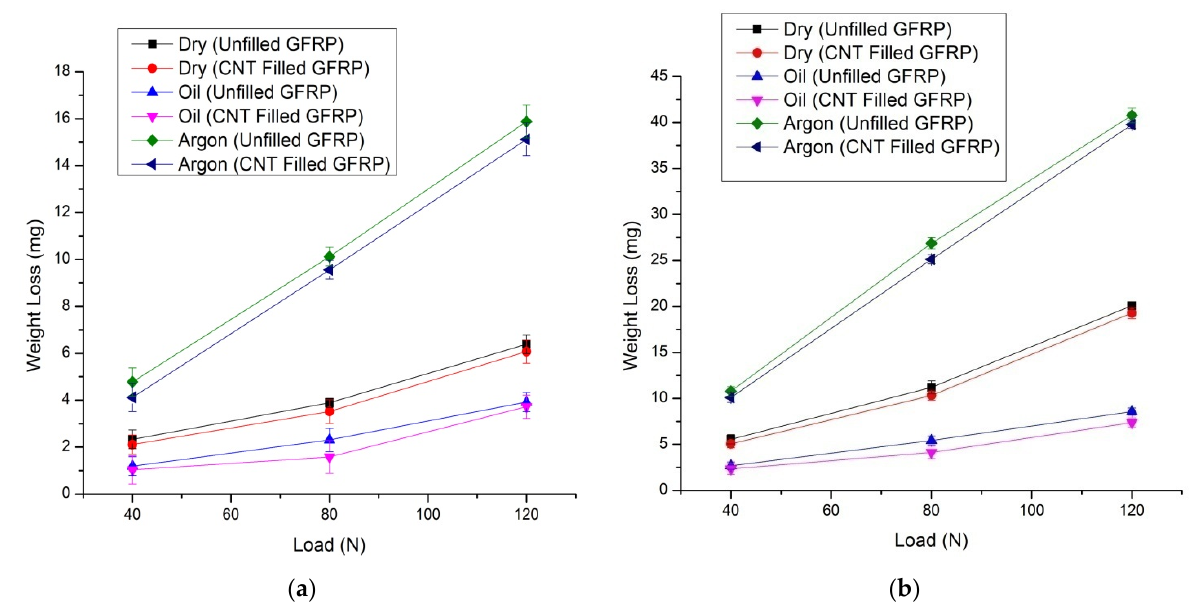
Figure 3. ( a ) Wt. Loss v/s Load for CNT-filled GFRP and unfilled GFRP composites under all three cases at 2.51 m/s and at 1508 m and ( b ) Wt. Loss v/s Load for CNT filled GFRP composites, during all the three cases at 3.14 m/s and for 2828 m.